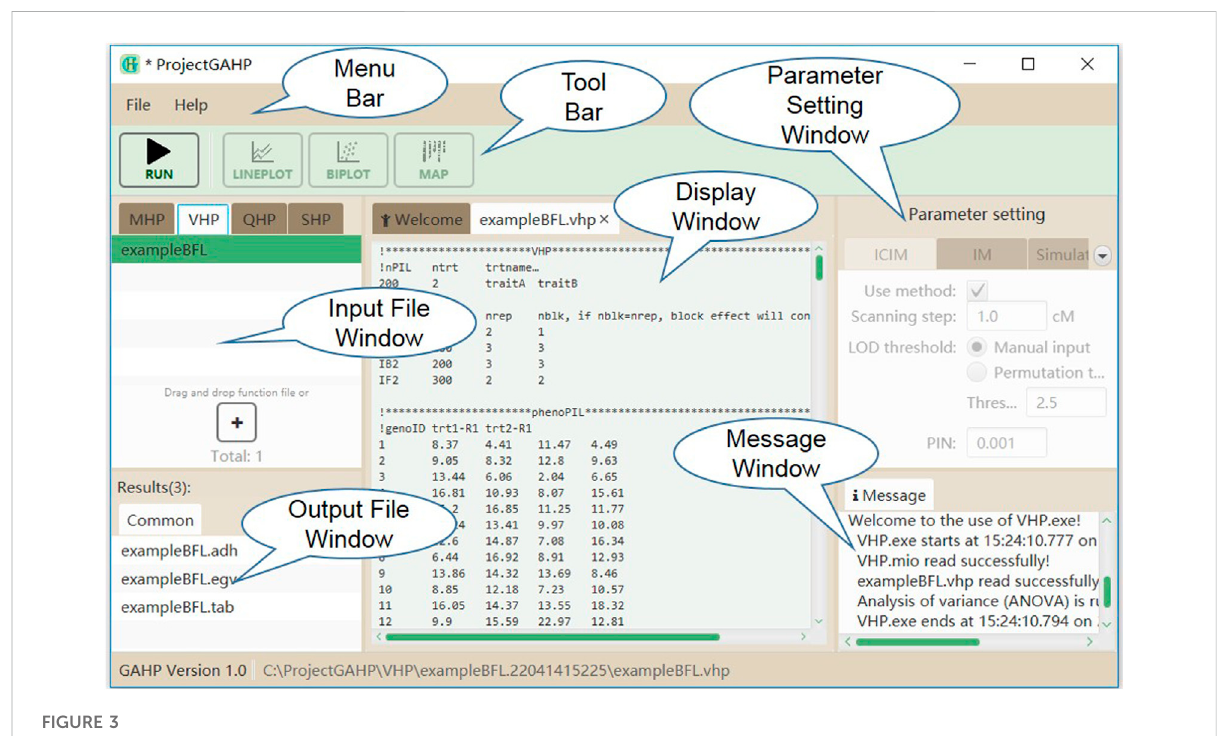
FIGURE 3 The interface of functionality VHP.